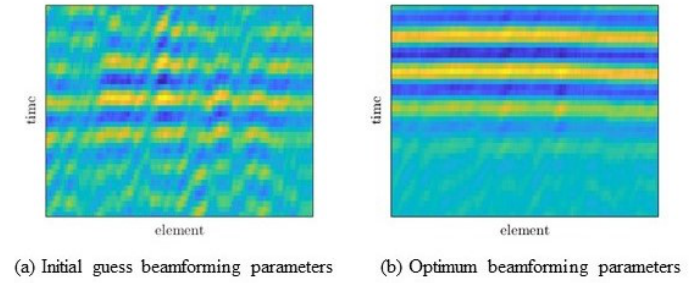
Figure 16. Experimental delayed RF data acquired from the phantom with the paraffin wax sample. CoMTUS flat backscattered echo from a point-like target, obtained by coherently adding the four delayed backscattered echoes from the same point-like target ( T 1 R 1 , T 1 R 2 , T 2 R 1 , T 2 R 2 ) using different beamforming parameters: ( a ) initial guess values; ( b ) optimum